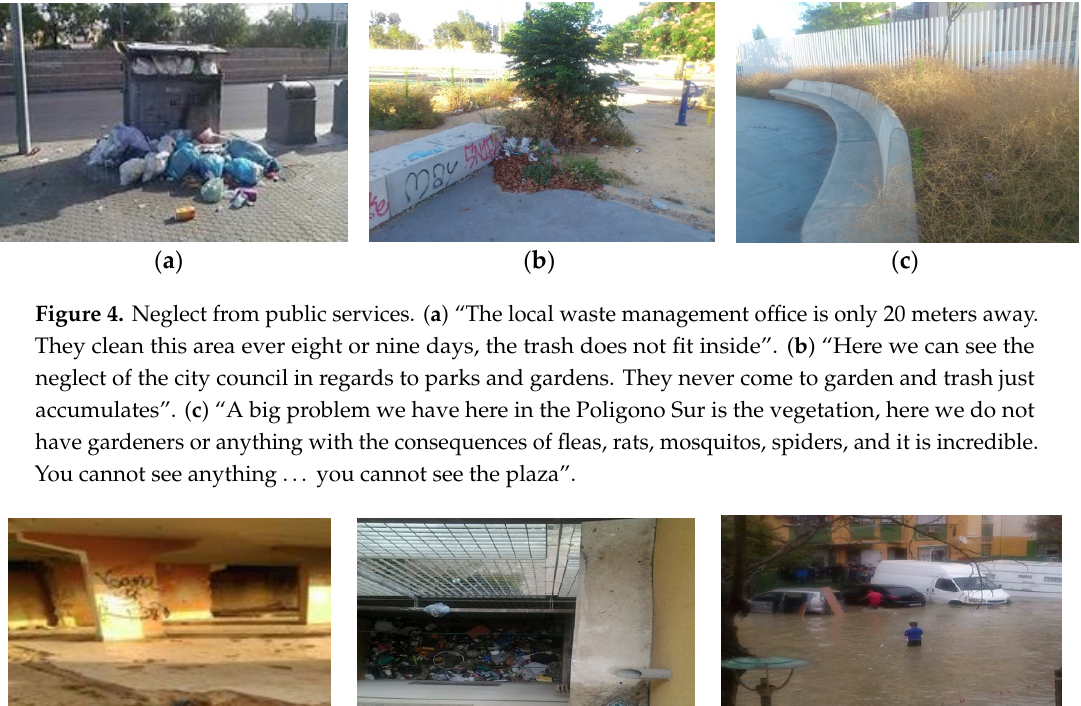
( c ) Figure 3. Unhealthy public spaces. ( a ) ¨There are around 40 or 50 homes and only one trash bin trash is left near the trees, the rats, mosquitos, insects, the situation is unbearable, the neighborhood is very dirty”. ( b ) “There used to be two football fields. People used to play football here. I would look out the window and watch. They were going to begin construction here and took away the field and now it has turned into this”. ( c ) “There are limited places for leisure. Perhaps three or four. They accumulate trash and things are left broken”. Neglect from Public Services Neighbors expressed an overall sense of abandonment from public services such as the waste management, parks and gardening, mail, public transport, and the local policy committee responsible for coordinating actions in the district. The conversation oscillated between blaming other neighbors for the poor conditions of common spaces to the complete neglect from those responsible of providing services in the neighborhood. It was highlighted that, in parts of the neighborhood where non-Roma lived, the living conditions were drastically different. Figure 4 below represents photographs taken in different public spaces in PS and narratives of unhealthy public spaces. Neighbors then developed